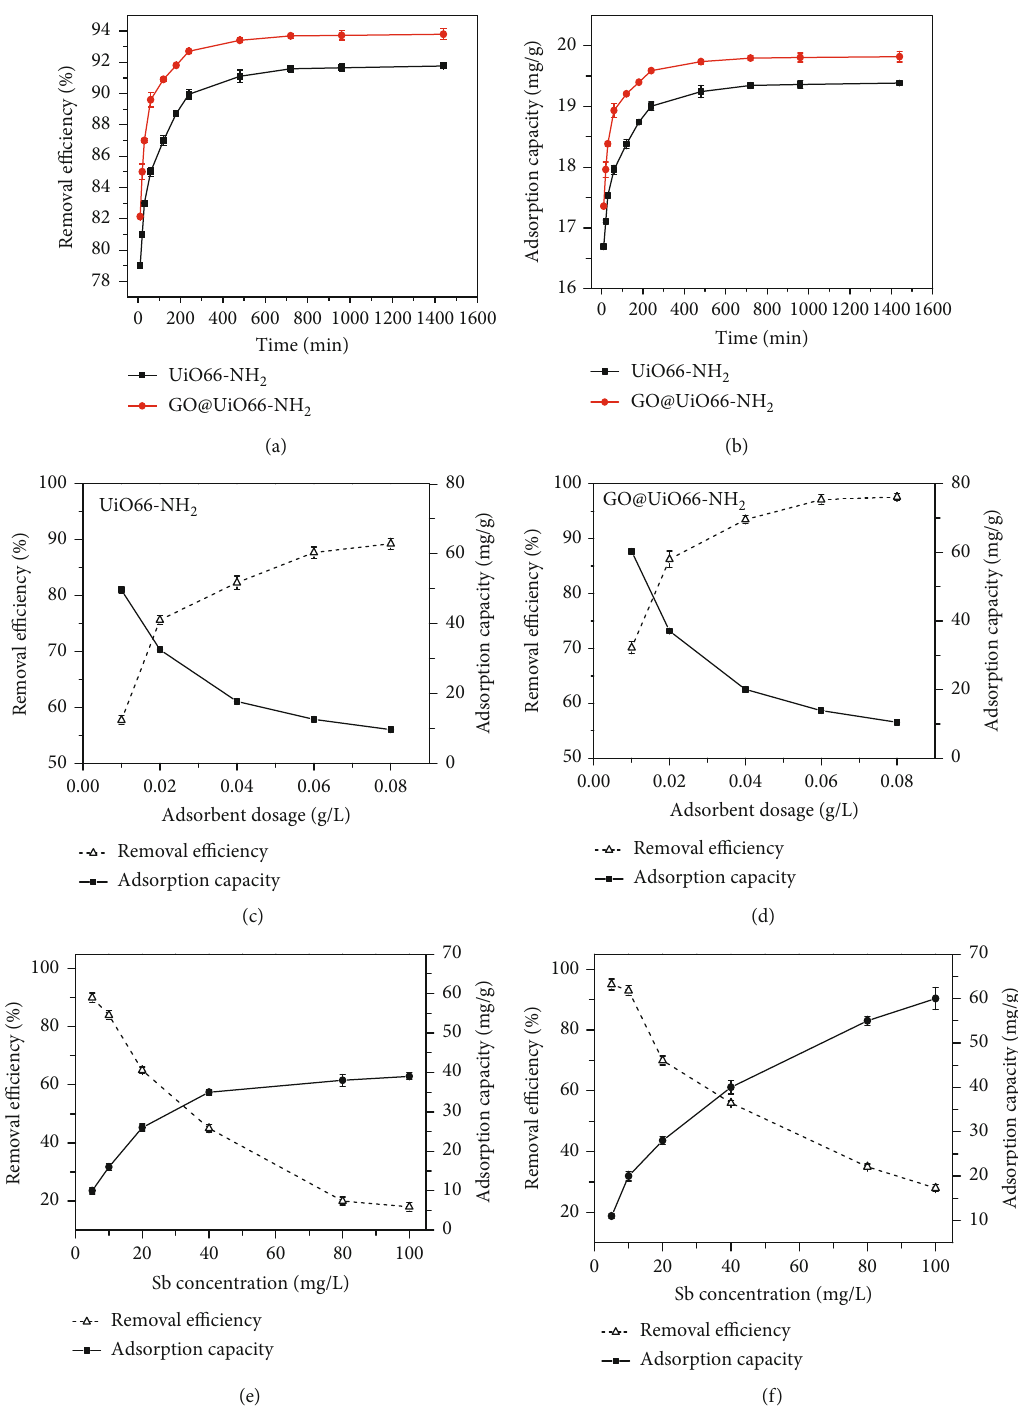
Figure 2: The e ff ect of contact time on the adsorption removal e ffi ciency (a) and adsorption capacity (b); the e ff ect of adsorbent dosage on (c) and GO@UiO-66-NH (d); the e ff ect of initial Sb (III) concentration on the adsorption of Sb the adsorption of Sb (III) by UiO-66-NH 2 2 (III) by UiO-66-NH (e) and GO@UiO-66-NH 2 2